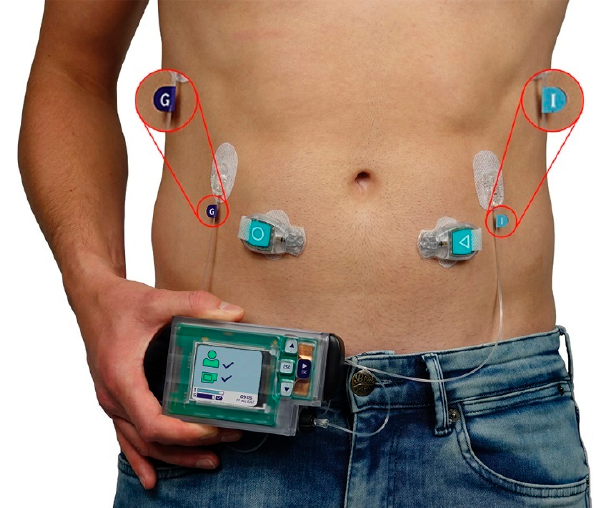
Figure 1. Representation of the AP™ as it generally is worn by T1DM patients. Here, the main- frame, as shown in the subject’s right hand, at least consists of the main processor, regulatory hormones, and an accelerometer. Furthermore, the transmitters, depicted by the devices with a circle and triangle, contain the blood glucose sensors and accelerometers. Finally, the cannulas (purple G and blue I) serve as an injection spot for the regulatory hormones [1].